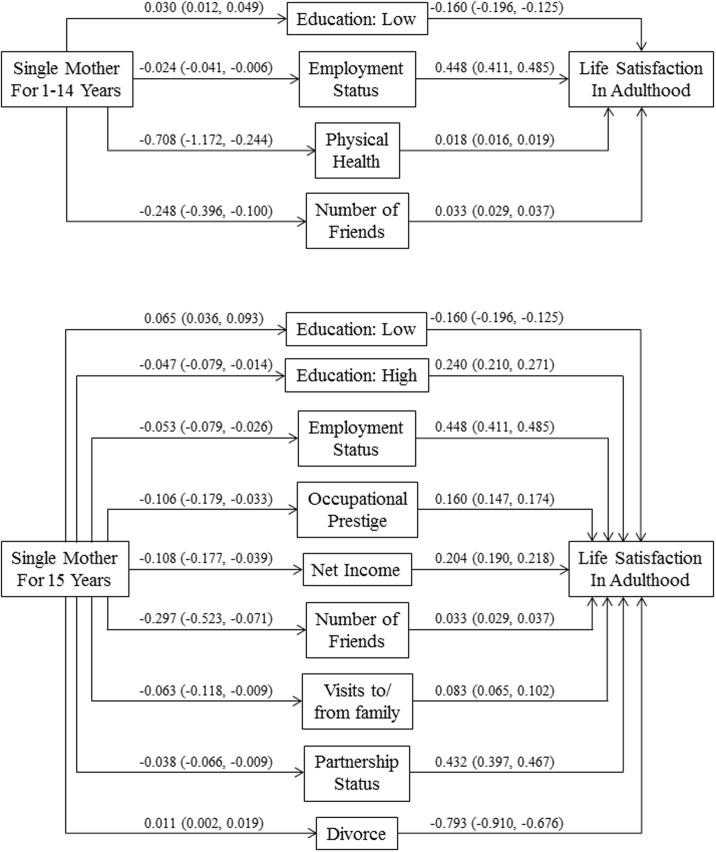
Results of path model estimating indirect effects from childhood family settings to adult life-satisfaction via adulthood life circumstances.Indirect paths were estimated separately in individual models but illustrated here together in one model for presentational parsimony. All models controlled age, age2, age3, sex, and childhood SES. Values are unstandardized path coefficients with 95% confidence limits. Life satisfaction, occupational prestige and net income were standardized; employment status, physical health (number of doctor visits, reverse coded), number of friends, visits to/from family, partnership status, and having been divorced were centered.